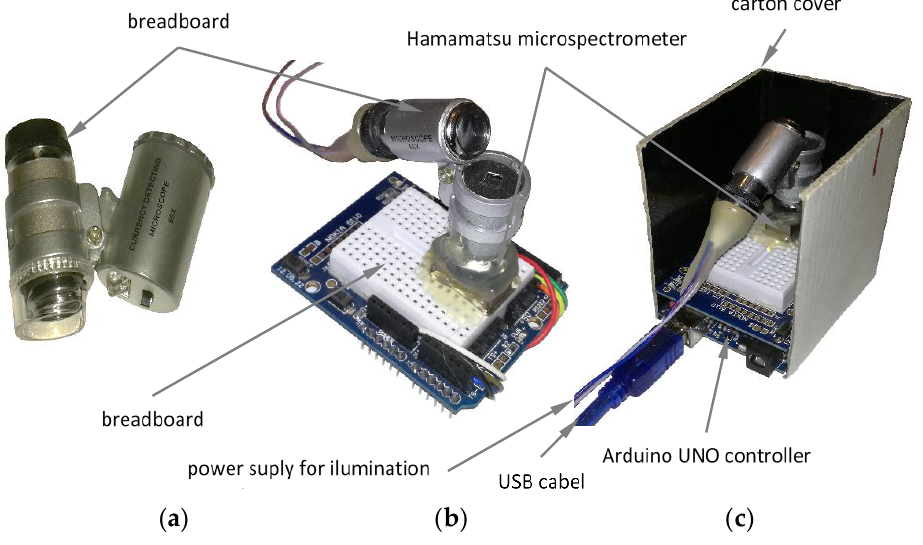
Figure 3. Focusing optics used in prototype spectrometers ( a ), the lenses, spectrometer with illumination installed on the breadboard ( b ) and assembled instruments ready for measurements ( c ).